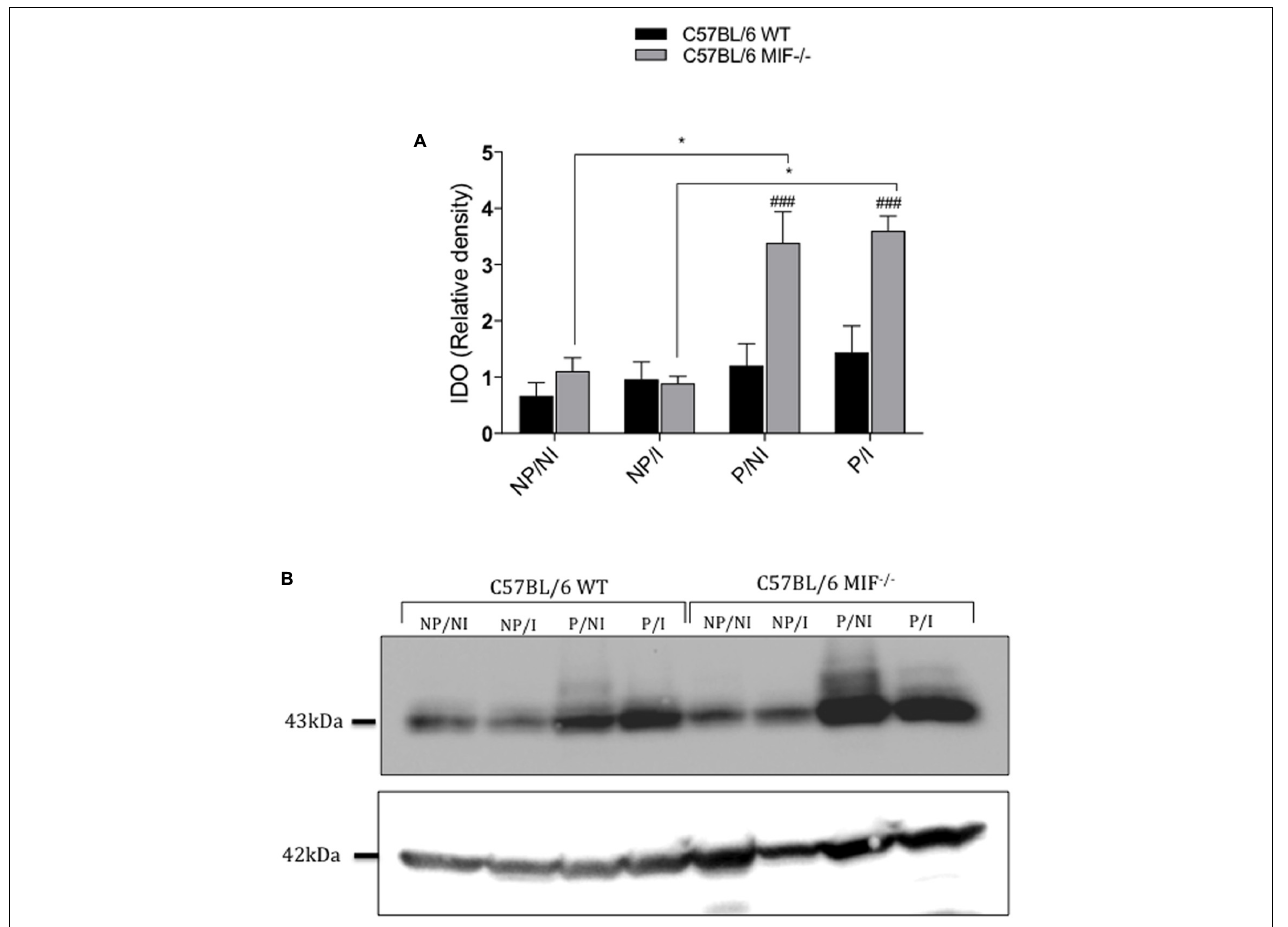
FIGURE 5 | Indoleamine 2,3-dioxigenase (IDO) expression in uterus homogenates from pregnant and non-pregnant C57BL/6 MIF − / − and C57BL/6 WT mice orally infected with Toxoplasma gondii. Uterus tissue samples were collected within 8 days of infection/pregnancy. Uterus tissues from non-infected pregnant and non-pregnant mice were used as controls. (A) IDO densitometric analyses are expressed as the relative density of the ratio between IDO and β -actin bands. Data are presented as mean and SEM of uterus samples ( n = 5 animals per group). # Significant differences between MIF − / − and WT mice in the same experimental condition ( ### P < 0.001). ∗ Comparisons between multiple experimental conditions within the same group (NP/NI, non-pregnant/non-infected; NP/I, non-pregnant/infected; P/NI, pregnant/non-infected; P/I, pregnant/infected) are indicated by bars ( ∗ P < 0.05). Data were compared by the Kruskal–Wallis test and Dunns’ multiple comparison post-test. (B) Representative cropped blots for IDO (43 kDa) and β -actin (42 kDa). All sample in the same gel were run simultaneously. Blots were probed with mouse anti-IDO and then stripped and reprobed with mouse anti β -actin, as a load